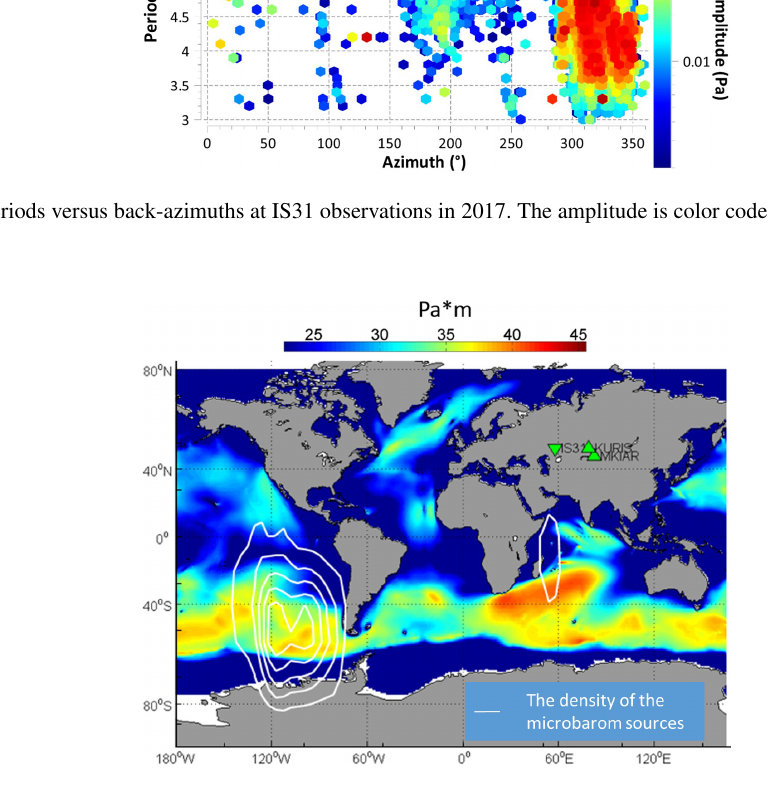
Figure C2. Spatial distribution of the epicenters of microbarom sources in July–August 2017. White contours represent the density of the microbarom source locations obtained via cross-bearing using detections at IS31, KURIS, and MKIAR, during same time periods. At each station, back-azimuths are daily